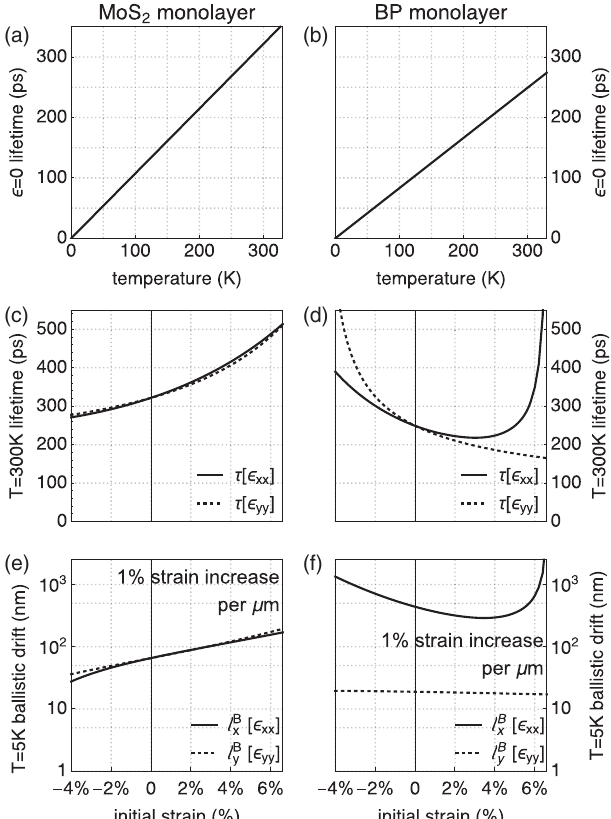
FIG. 4. (a,b) Temperature dependence of exciton lifetime τ without strain, and (c,d) lifetime versus uniaxial strain at room temperature, obtained from Eqs. (1) and (2). (e,f) Ballistic exciton funnel distances l B before recombination at T ¼ 5 K, as a x;y , when subjected to a 1% uniaxial function of initial strain ϵ 0 ii strain increase per micrometer traveled. This measures the efficiency of the funnel effect along each uniaxial strain